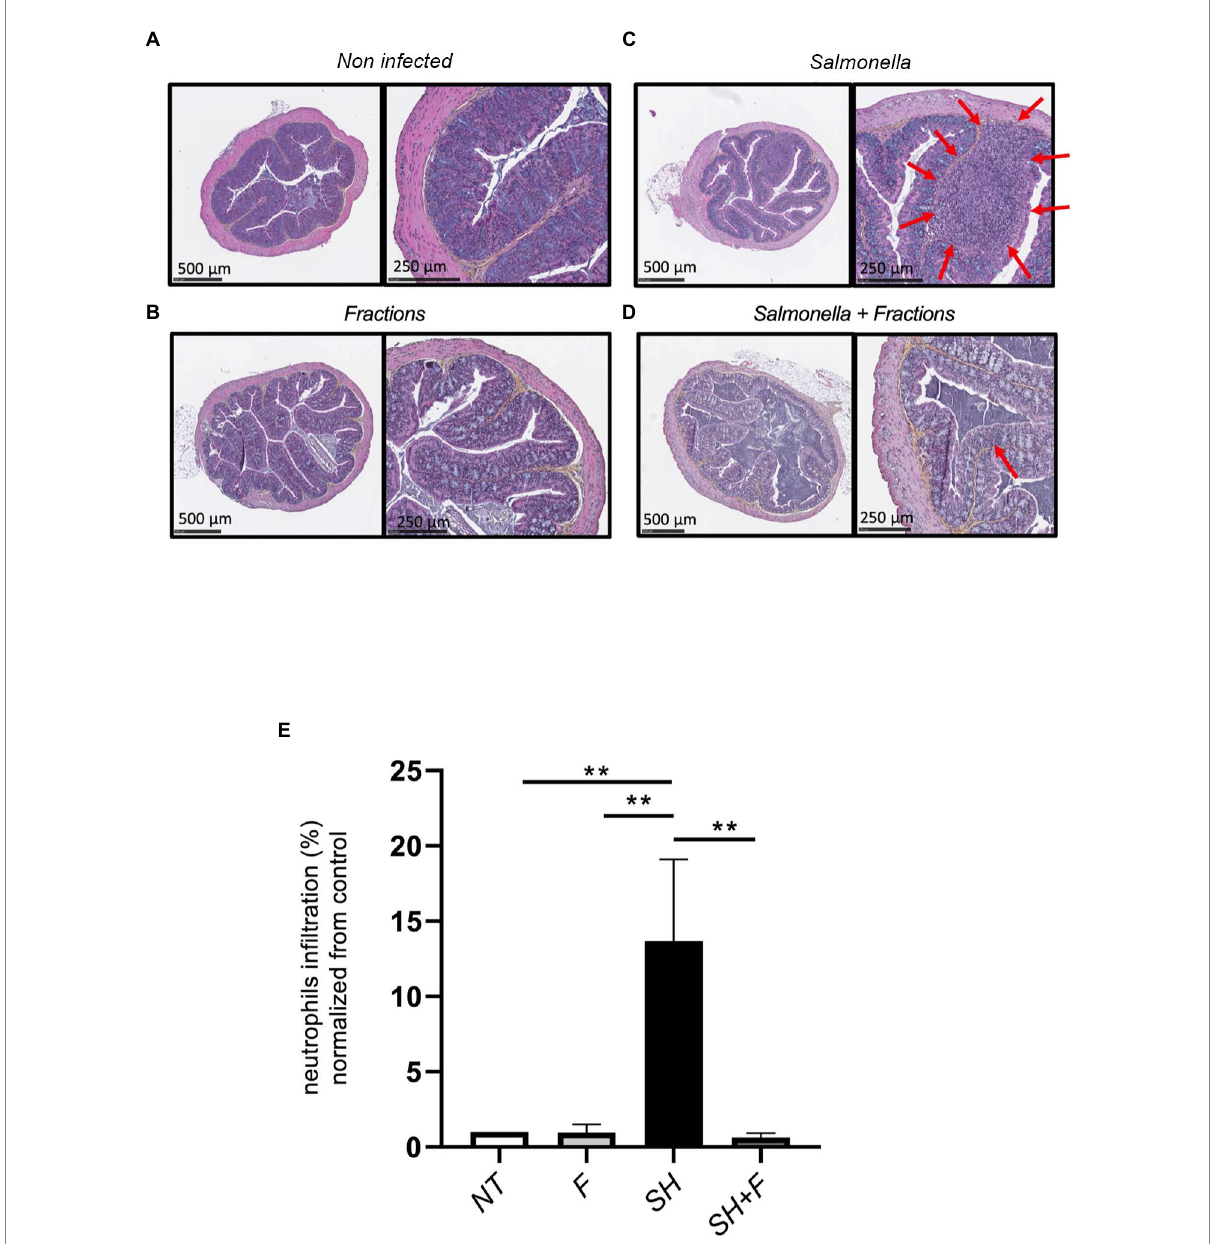
FIGURE 3 Bioactive fractions inhibited neutrophils infiltration in mice colon. (A) Histologic analysis of the colon of untreated mice (NT), (B) mice treated by bioactive fractions alone (F), (C) mice infected by Salmonella Heidelberg alone (SH), and (D) mice receiving Salmonella and bioactive fractions (SH + F). H&E stained cross-section of the colon of mice of each group showed the presence of neutrophils infiltration (red arrows) in Salmonella group only, which was decreased when the bioactive fractions were administered. (E) Quantification of neutrophils was represented by % of neutrophils infiltration normalized from the control. Scale bar: 500 and 250 μ m. ANOVA one-way statistical analysis test was used for n = 5, normality of data was evaluated by Shapiro test. Data were represented by SEM bars ** p <